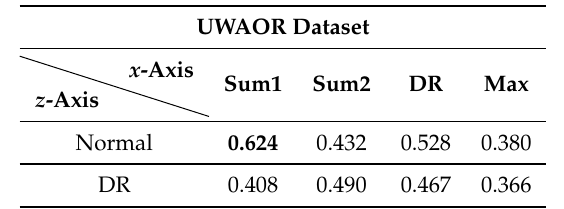
Table 7. MeanCos performance of eight different combinations on UWAOR Dataset.